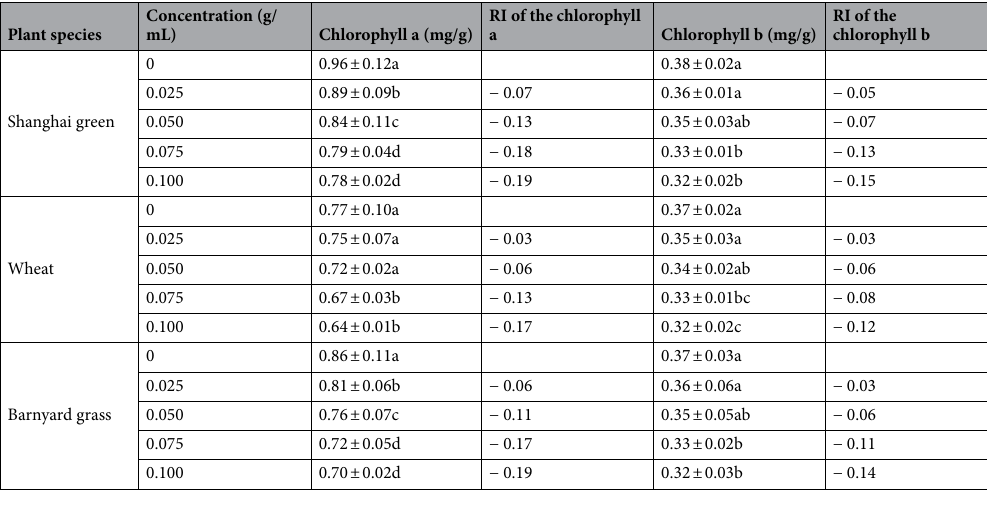
Table 4. Effects of different concentrations of water extracts from the leaves of Flaveria bidentis on the chlorophyll a and chlorophyll b contents of three plants. Data are shown as the mean ± standard deviation. Different letters in the same column in each treatment indicate significant differences at the P < 0.05 level, while the same letter indicates no significant difference at the P < 0.05 level.